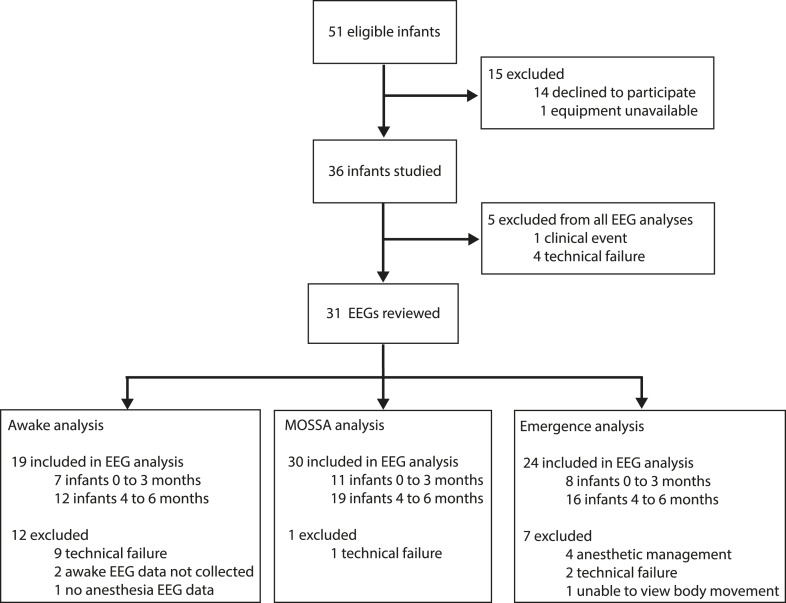
Study profile.Parents of 51 infants were approached and 36 consented. Five EEG recordings were excluded from the final analysis because of technical failures (n = 4) or a clinical event (n = 1; local anesthetic toxicity prior to surgical incision). For MOSSA analysis, data are presented from 30 EEG recordings (0–3 months, n = 11; 4–6 months, n = 19); for awake analysis, 19 infants were included (0–3 months, n = 7; 4–6 months, n = 12); and for emergence from general anesthesia analysis, 24 infants were included (0–3 months, n = 8; 4–6 months, n = 16).